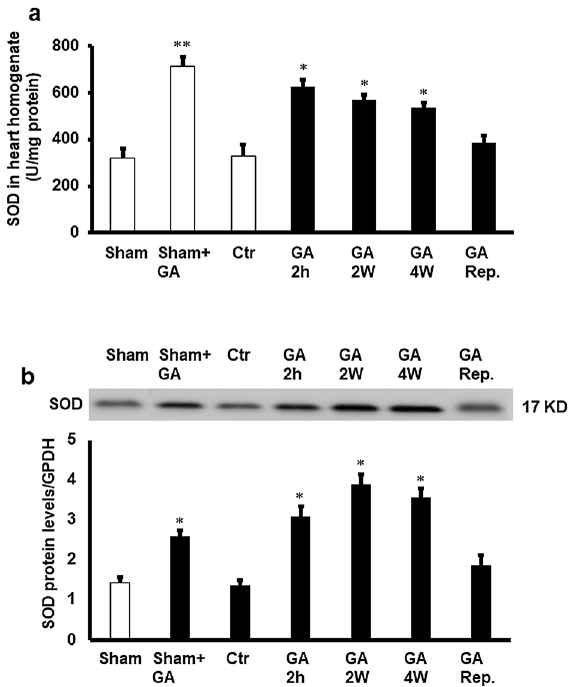
corrected to GAPDH. Bottom: SOD protein levels corrected to GAPDH. SOD in cardiac muscle samples after GA administration for 2 weeks, 4 weeks, or 2 h before sacrifice or at reperfusion compared to the levels in the control group (n = 4). Ctr control, GA 2 h Gum Arabic infusion 2 h before sacrifice, GA 2 W Gum Arabic administration for 2 weeks, GA 4 W Gum Arabic administration for 4 weeks, GA Rep . Gum Arabic infusion at reperfusion. *P < 0.01 compared to control and **P < 0.01 compared to control and vehicle treated sham. Full length gels were included in supplementary figure (Fig.